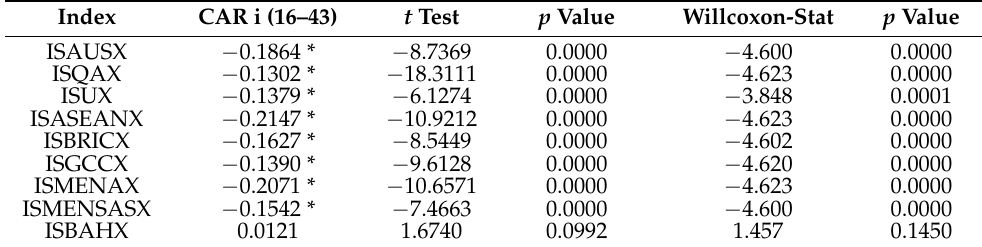
Table 5. Cumulative abnormal return in long-term